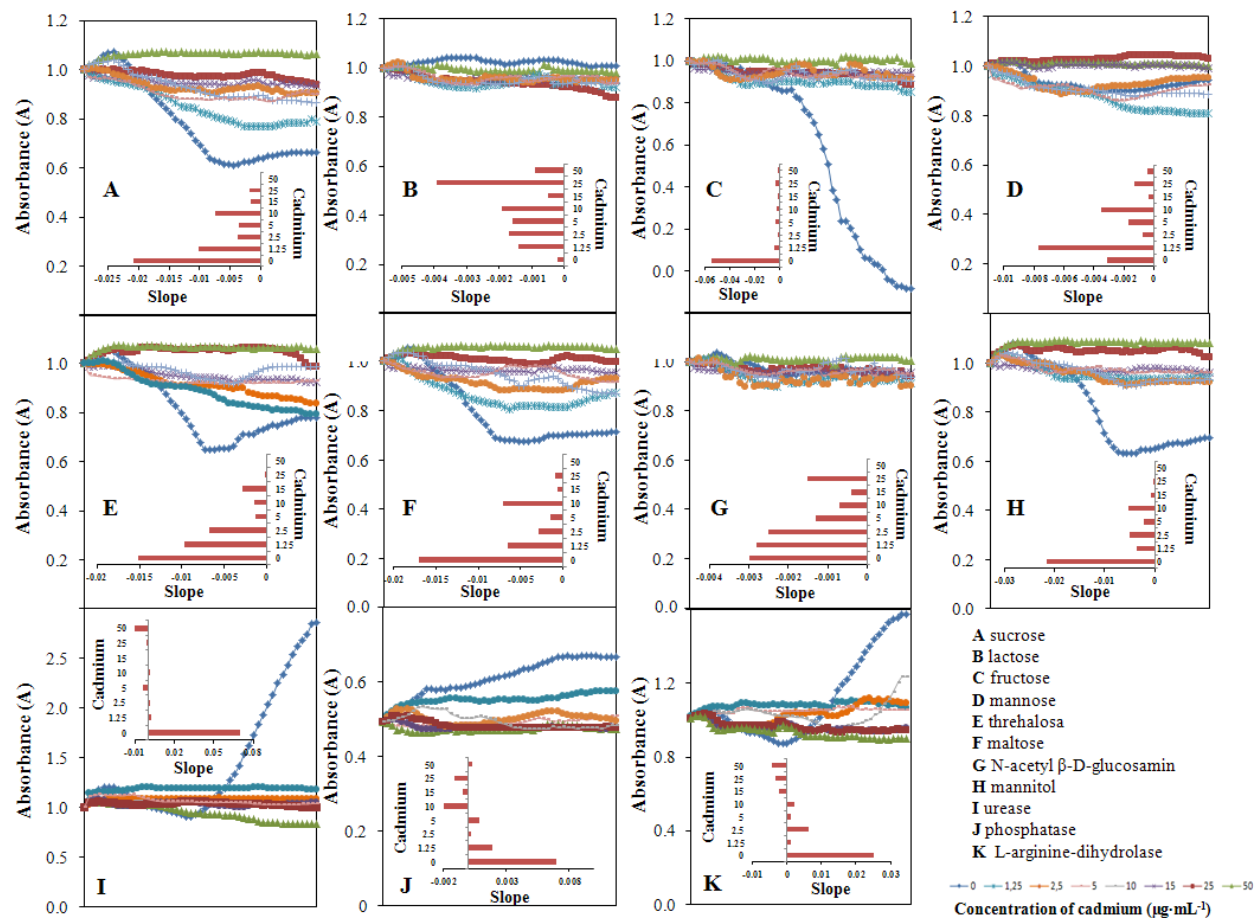
Figure 7. Spectrophotometric detection of S. aureus metabolism through determination